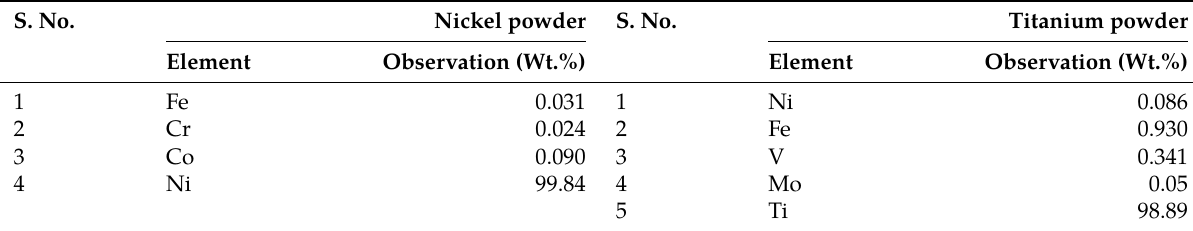
Table 1: Chemical composition of nickel and titanium powder. S. No.